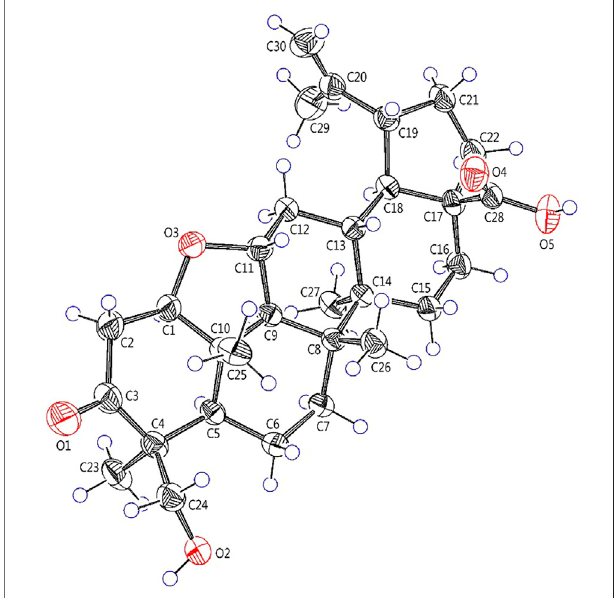
FIGURE 5 | X-ray crystallographic structure of 2